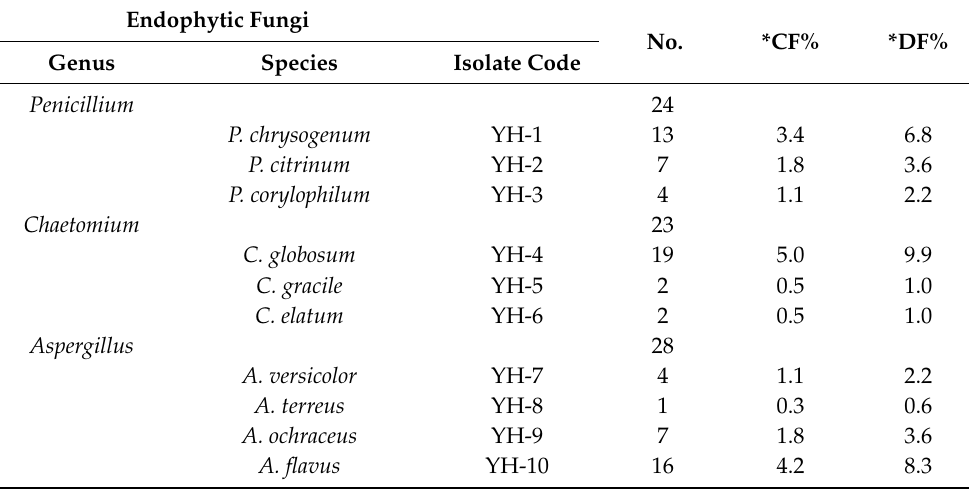
Table 1. Isolation, colonialization and dominance frequency of endophytic fungi from plant leaf of Z. spina-christi